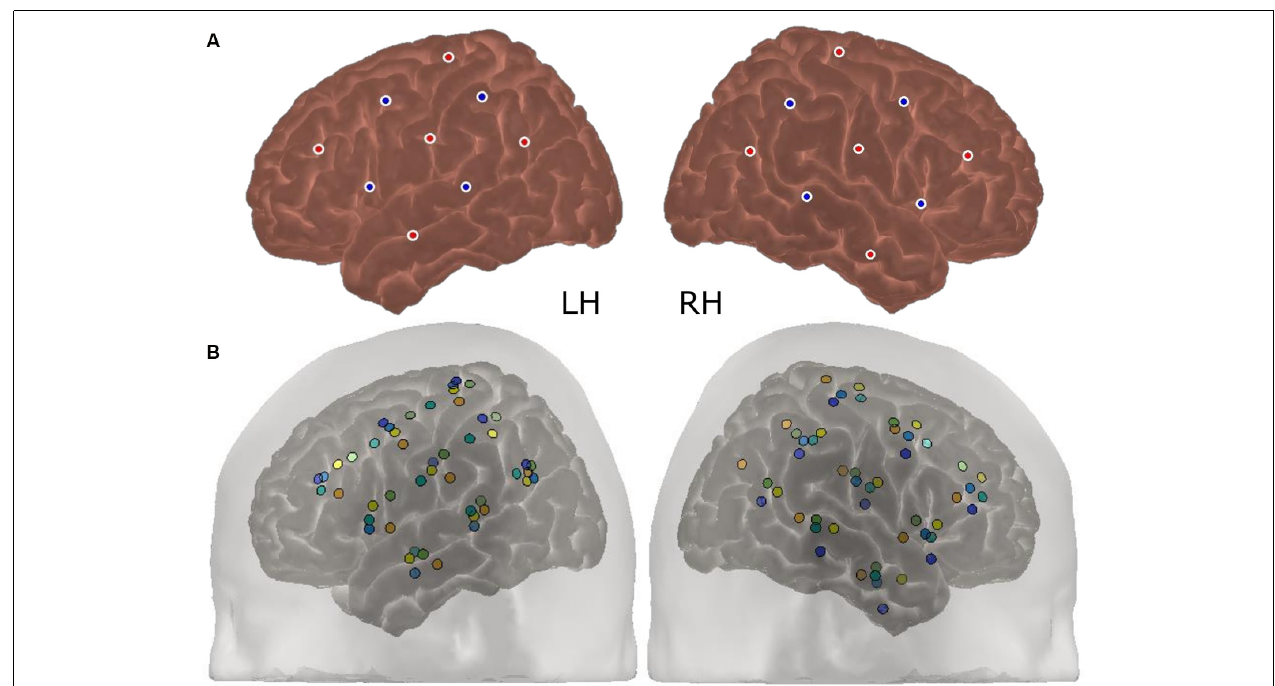
FIGURE 4 | Average and individual optode positions of the array ( N = 6). The average optode registration positions across six participants are shown in panel (A) for each cerebral hemisphere. The red dots represent fNIRS emitters and the blue dots represent detectors. Individual registrations, which are color-coded per participant, are displayed in panel (B) . The standard deviation in the position of each optode ranged between 5.7 and 11.6 mm.